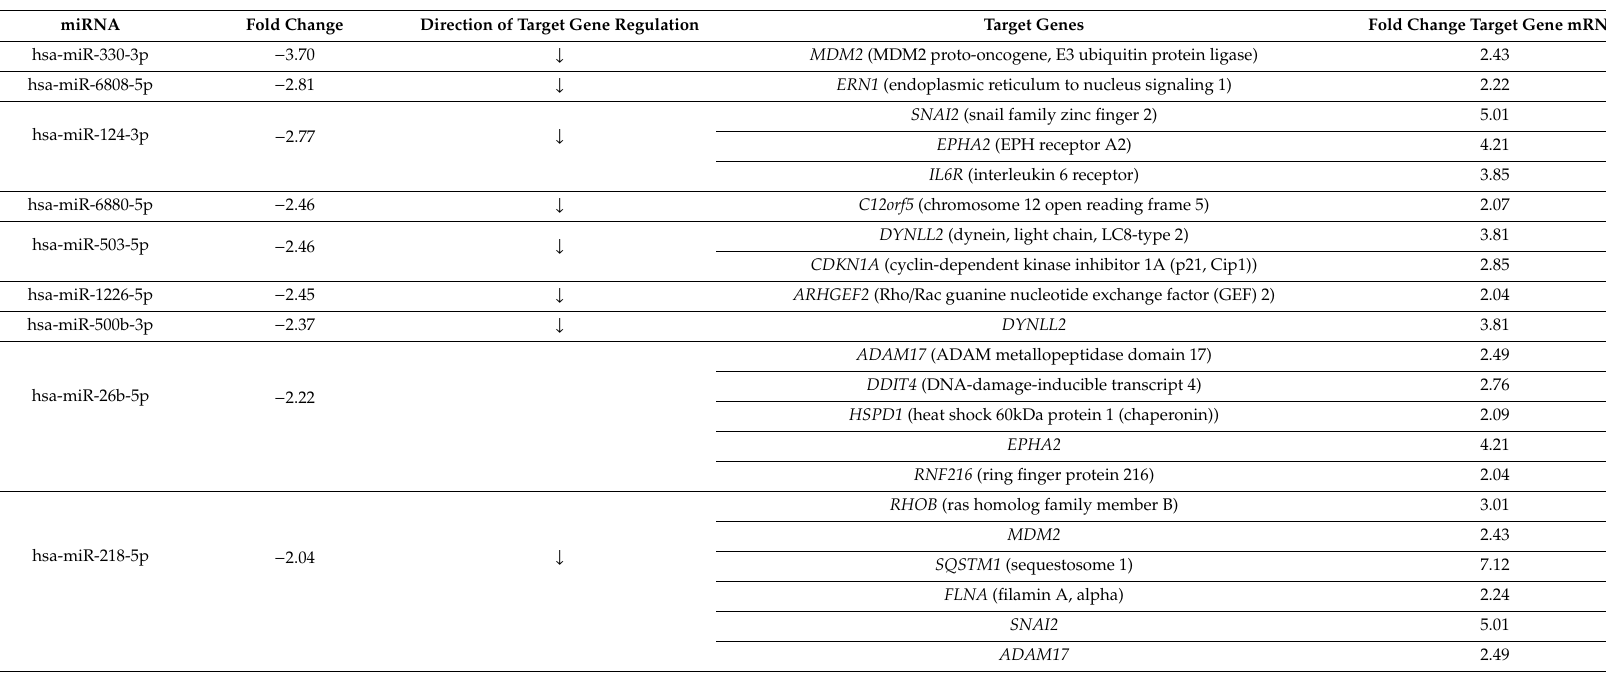
Table 7. The list of most dysregulated miRNAs with their pro-apoptotic targets in bortezomib-treated SH-SY5Y cells compared to controls. Presented miRNAs downregulate expression of their target genes, hence the direction of target genes regulation is marked as “ ↓ ”. Since all miRNAs have decreased expression (negative fold change), the downregulation of their targets is not prominent and therefore they present with positive fold change, which indicates increased expression of pro-apoptotic